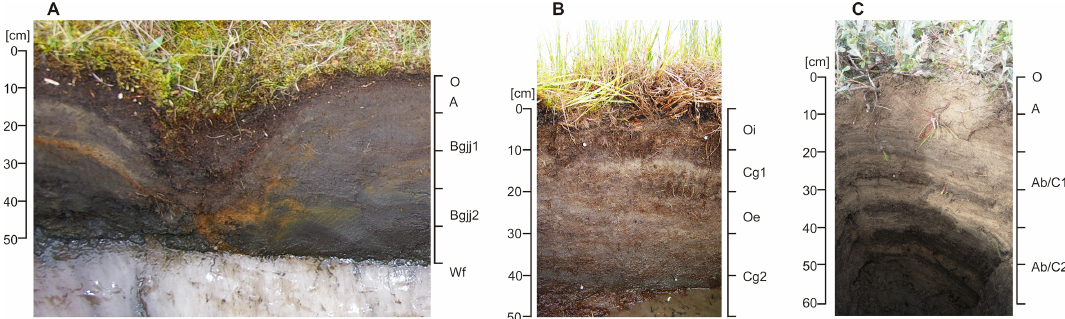
Fig. 2. Representative soil types dominating Samoylov Island. (A) Glacic Aquiturbel , a cryoturbated permafrost-affected soil with redox depletions and aquic conditions as well as a glacic layer within 100cm of the mineral soil surface. (B) Typic Historthel , a non-cryoturbated permafrost-affected soil that have in 30% or more of the pedon organic soil material. (C) Psammentic Aquorthel , a non-cryoturbated sand- dominated permafrost-affected soil with redox depletions and aquic conditions during normal years. Soil classification according to the US Soil Taxonomy (Soil Survey Staff, 2010). Photograph of Psammentic Aquorthel : courtesy of Tina Sanders. Table 1. Selected exemplary soil chemical properties of three representative soil types dominating Samoylov Island (see also Fig. 2). Gravi- metric contents of organic carbon (OC) and total nitrogen (N) are expressed as percentages. Glacic Aquiturbel Typic Historthel Psammentic